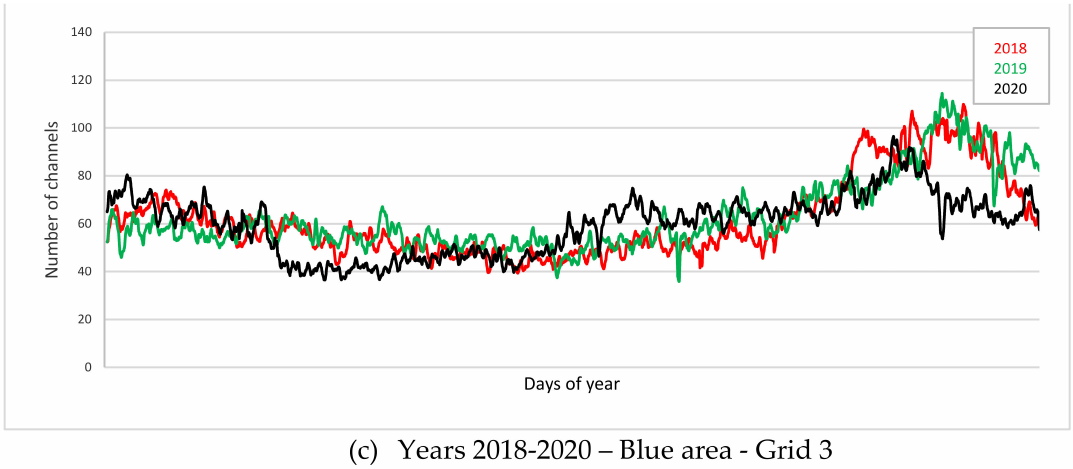
Figure 8. Results corresponding to the number of channels constituted from 2018 to 2020 in the blue geographical area under